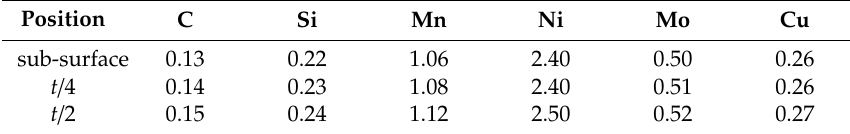
Table 4. Measured chemical composition of the experimental steel, in wt. %.